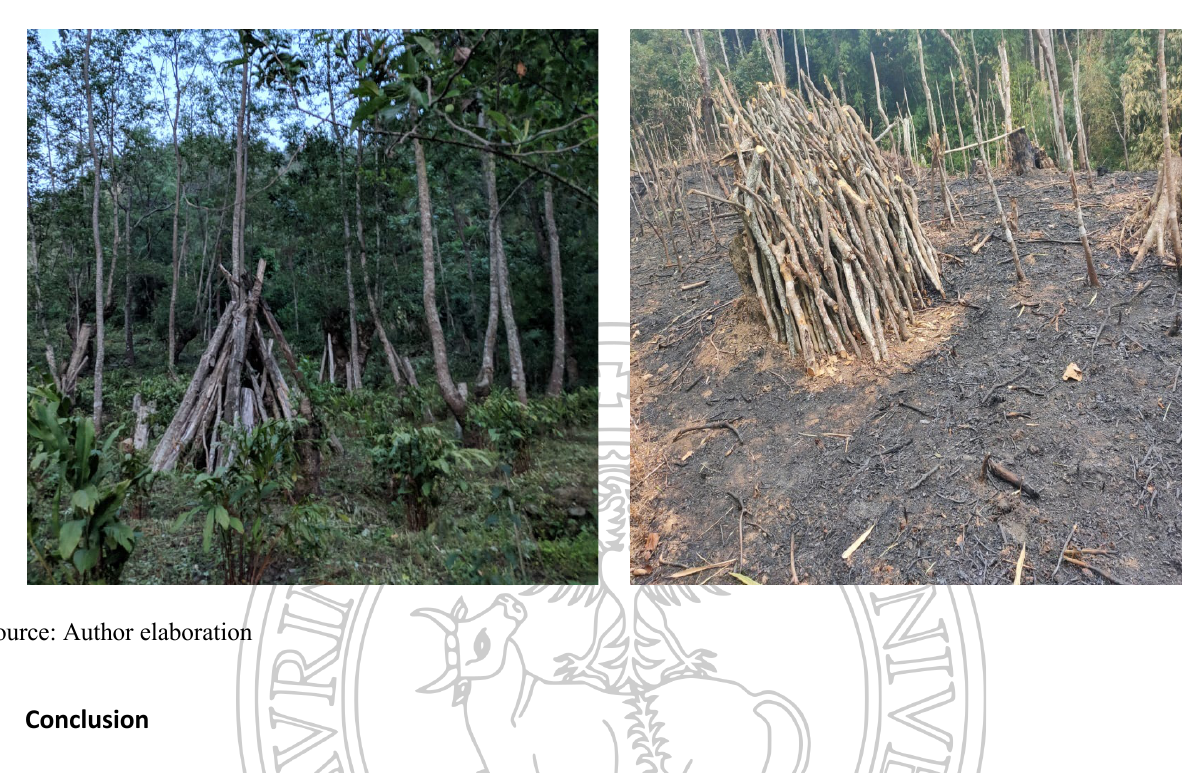
Figure 10 – Different methods of fuel wood harvest (a) : Phek (b) :